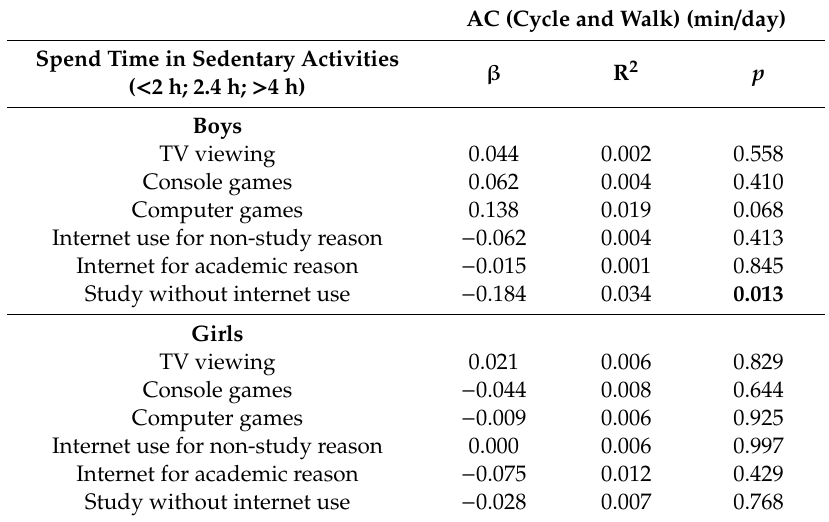
Table 4. Associations between AC and each sedentary activity during the week by divided by sex. AC (Cycle and Walk) (min / day) Spend Time in Sedentary